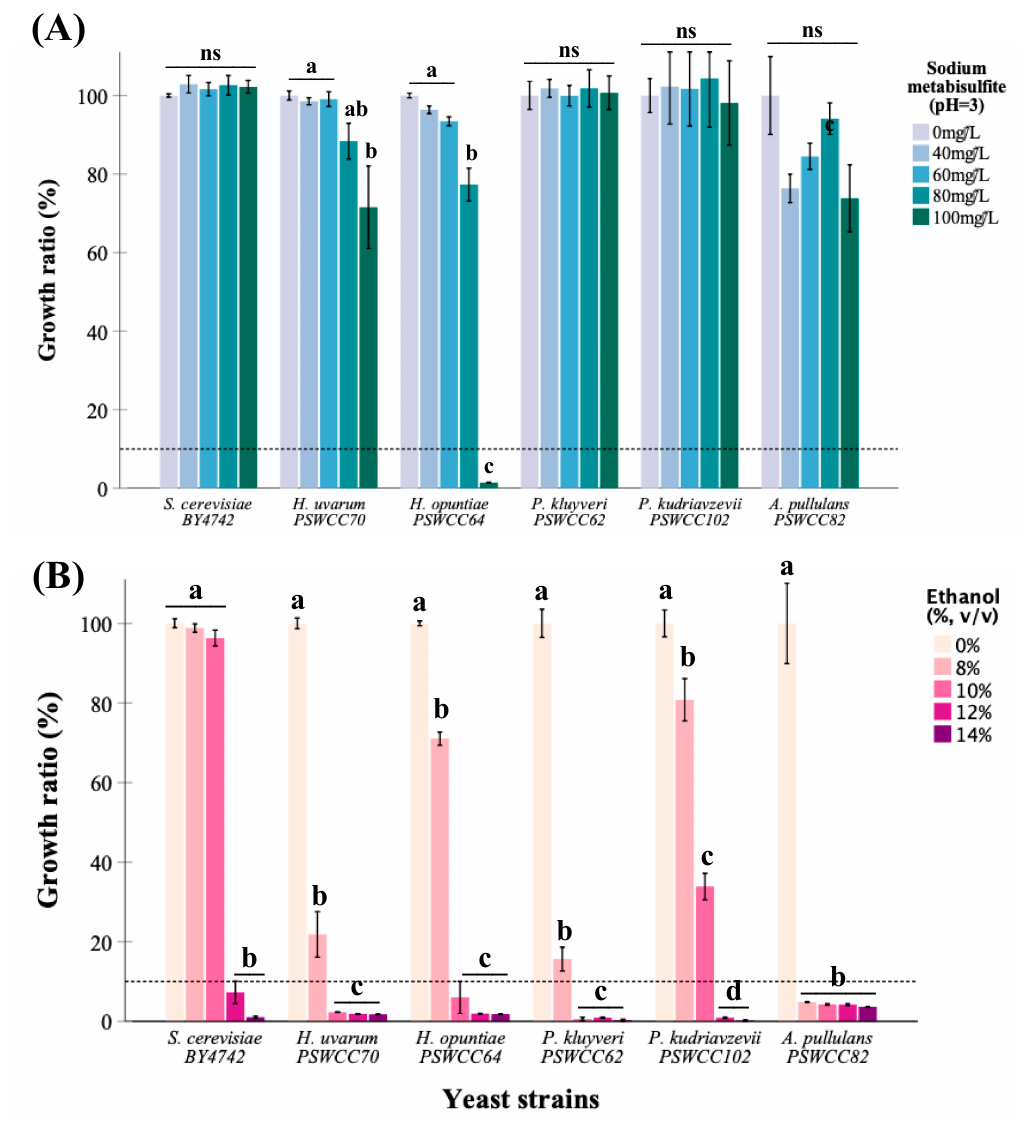
Figure 3. ( A ) Sulfite and ( B ) ethanol tolerance of candidate non- Saccharomyces isolates compared to laboratory control, S. cerevisiae BY4742. The heights of bar graphs represent tolerance which is defined as a ratio greater than 10% between growth of a strain in media supplemented with and without sulfite or ethanol. Yeast Peptone Dextrose (pH 3.0) was used as a growth medium for sulfite tolerance assay whereas YPD at pH 7.0 was used for ethanol tolerance (see Section 2). Dotted line across the y-axis represents a 10% cutoff. Strains used in this study are represented on the x-axis. Data is presented as mean ratio ± SEM with a common superscript indicating significance ( p < 0.05).